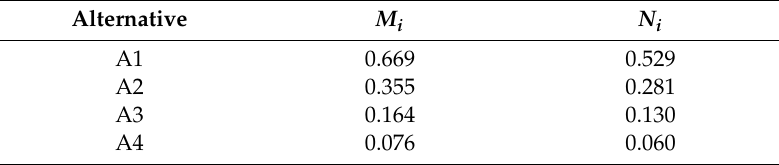
Table 8. Averaged and normalized values of the relative weights of the alternatives.